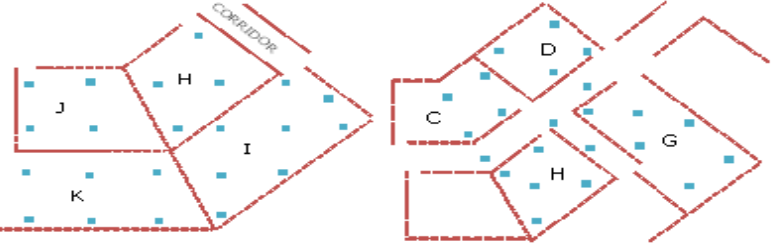
Figure 4. An example of points selected for training by the neural network.